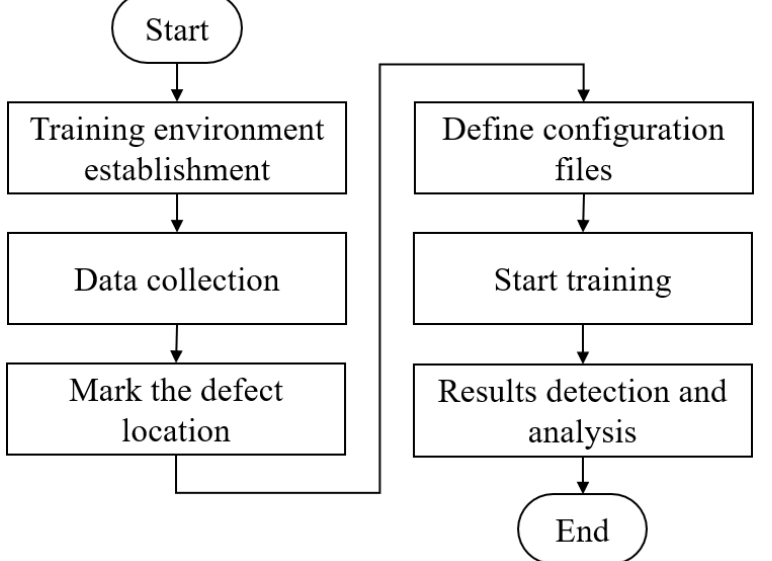
Figure 22. Flowchart showing experiments involving the application of original and generated images to YOLO v3 and YOLO v4.